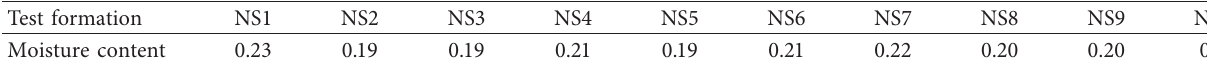
Table 4: The moisture content of each group of specimens containing cement.